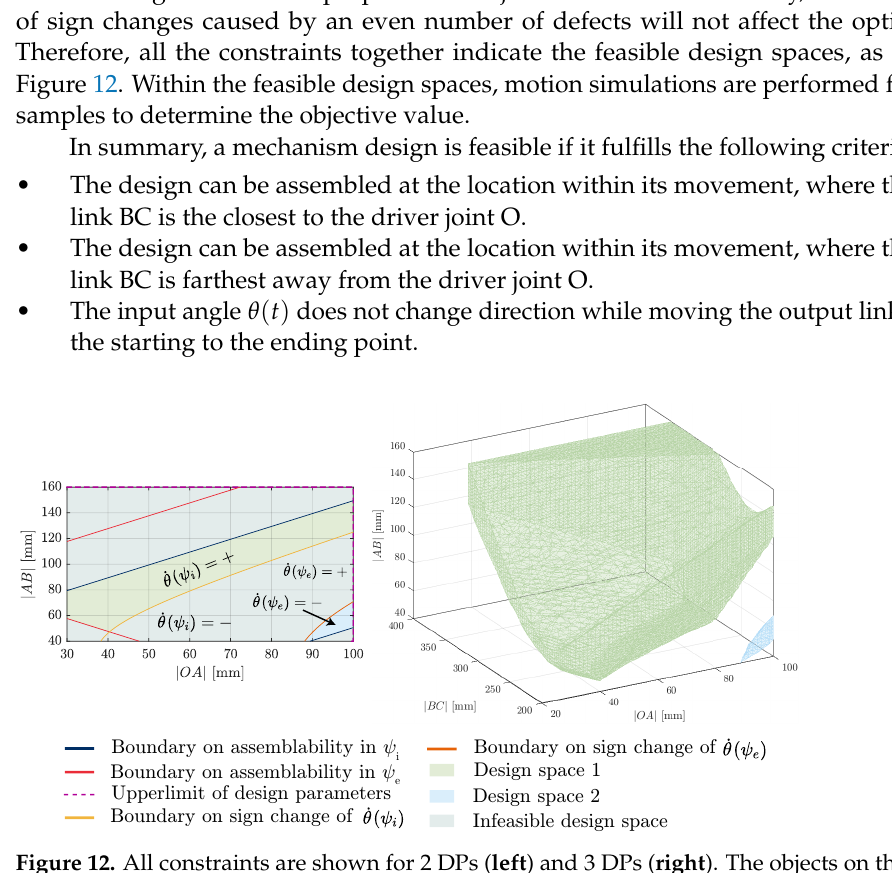
Figure 12. All constraints are shown for 2 DPs ( left ) and 3 DPs ( right ). The objects on the right are the feasible design spaces where the designs can perform the imposed reciprocal